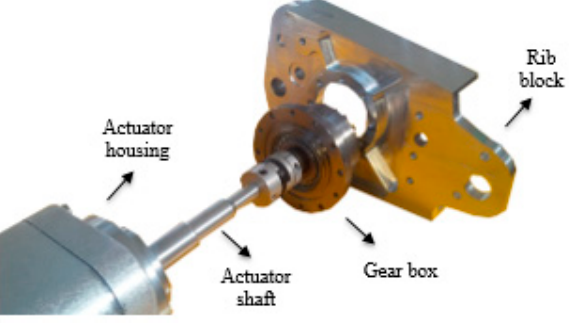
Figure 10. Actuation torque application.